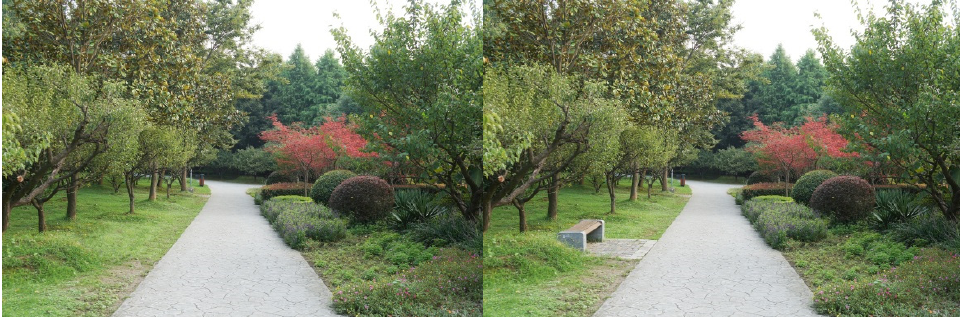
Figure 5. Example: Colorful flowers (herbaceous flowers were added).